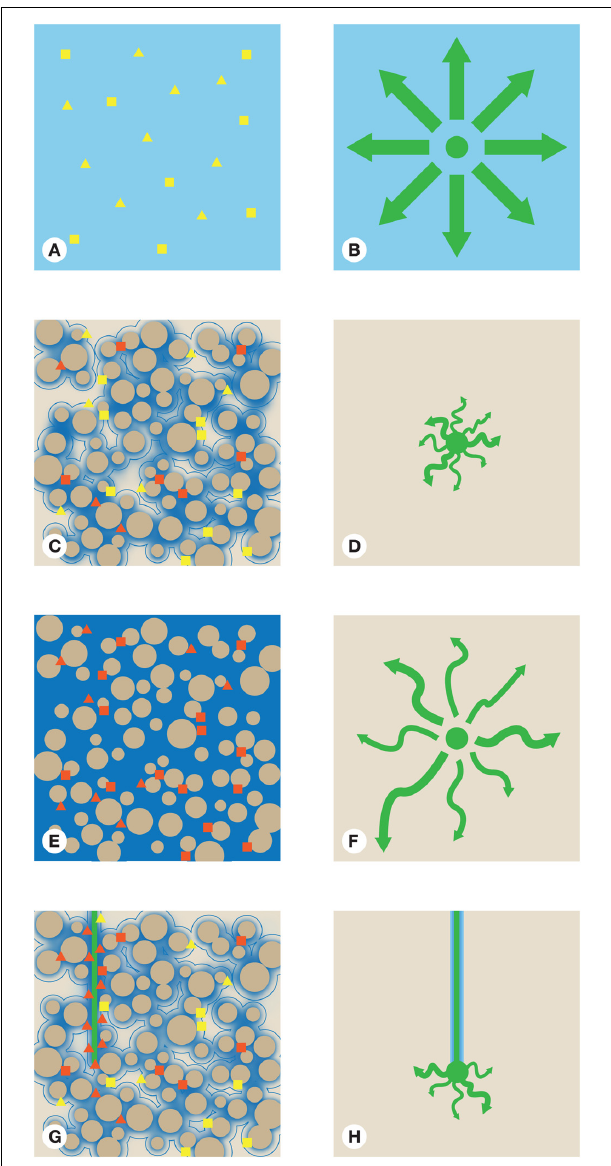
FIGURE 2 |The hypothetical location and activity of one bulk soil adapted bacterium (square) and one rhizosphere adapted bacterium (triangle). Bulk soil adapted organisms are assumed to be adapted for nutrient poor environments while rhizosphere organisms are assumed to be adapted for high nutrient environments in (A) a homogenous situation (C) unsaturated soil, (E) saturated soil, and (G) where a root is present. Water is represented by blue shading, the darker the the shade of blue the lower the O 2 concentration.The distribution and movement of a resource at one point in time is shown in (B) a homogenous situation (D) unsaturated soil, (F) in saturated soil, and (H) where a root is present.The • represents the resource at its source.The larger the dot the more resource left at that point. Arrows represent the potential movement of the resource away from the source by diffusion. All diagrams with the exception of (H) assume a system with no flow.The length of an arrow represents how far the resource has moved.The width represents the amount of resource moving in that direction.The straighter the arrow the straighter the path the resource is taking away from its source.The two bacterial species depicted as shapes are colored with the color denoting terminal electron acceptors as O 2 (yellow) and N compounds